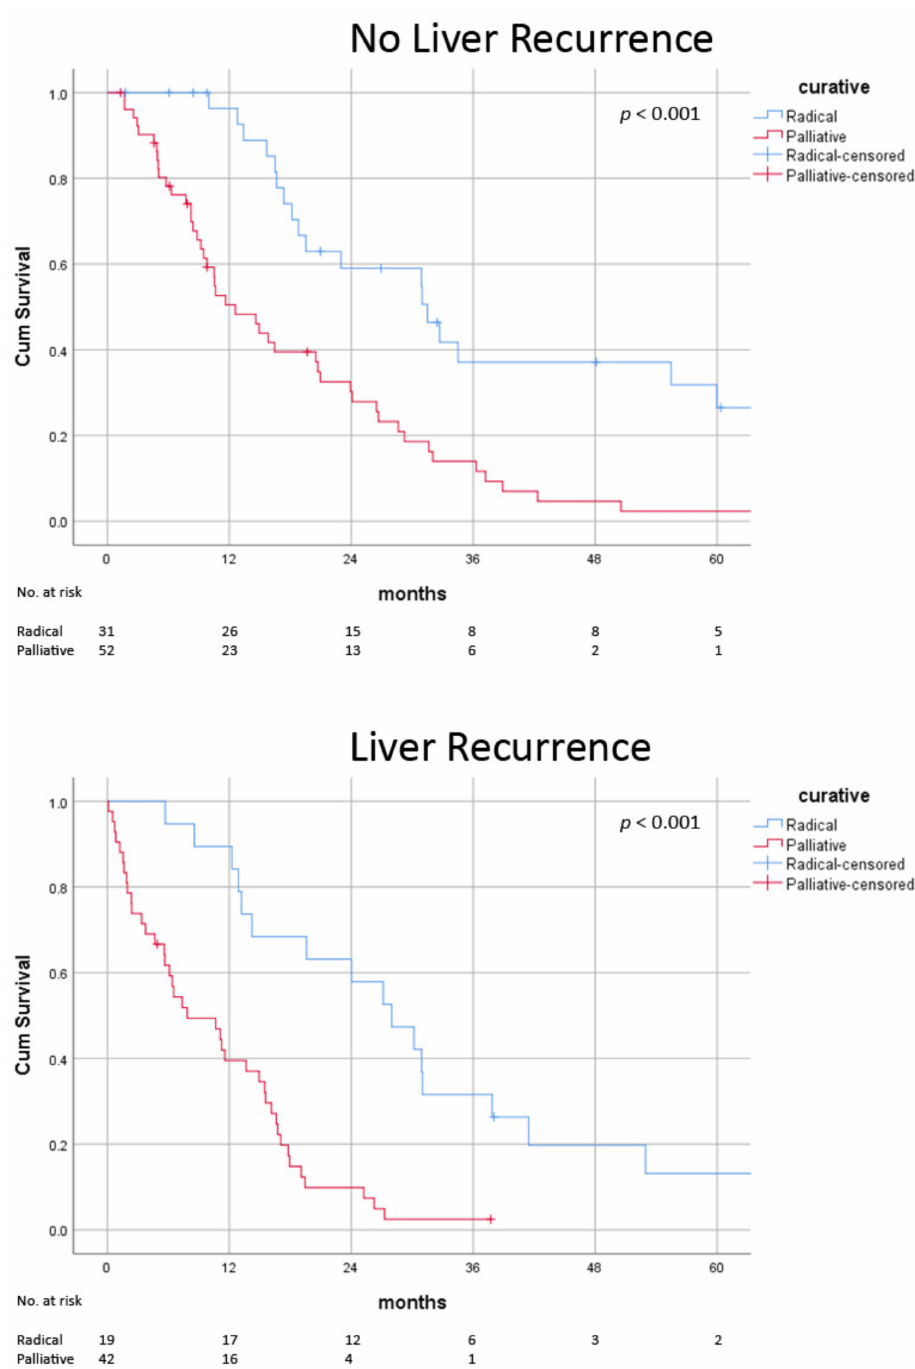
Figure 3. Post-recurrence survival of radical versus palliative treatment in absence and presence of liver